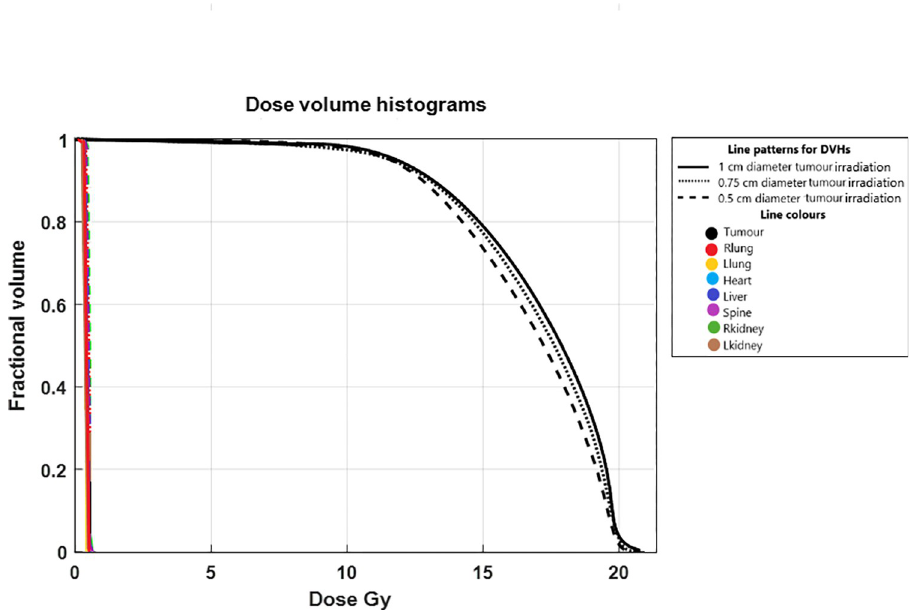
Fig 8. DVHs plots. DVHs of the tumours and OARs for 0.5 cm, 0.75 cm, and 1 cm tumour irradiations are demonstrated in dash, dot, and solid lines, respectively. DVHs of the tumours are in black and colours of the DVHs for OARs are presented in the